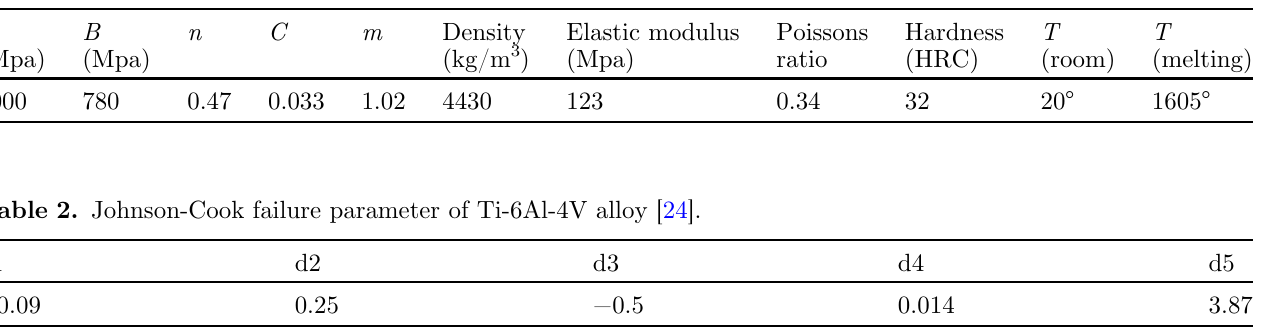
Table 1. Johnson-Cook parameters and mechanical properties of Ti-6Al-4V [24].